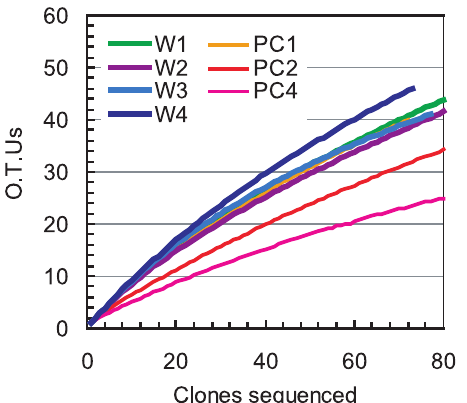
Figure 5. Rarefaction curves for the different phylotypes obtained from 16 S rRNA gene clone libraries. The raw primary clarifier effluent samples were collected at day 14 (PC1), day 152 (PC2), and day 304 (PC4). The anode biofilm samples were collected on day 44 (W1), day 133 (W2), day 263 (W3), and day 294 (W4).